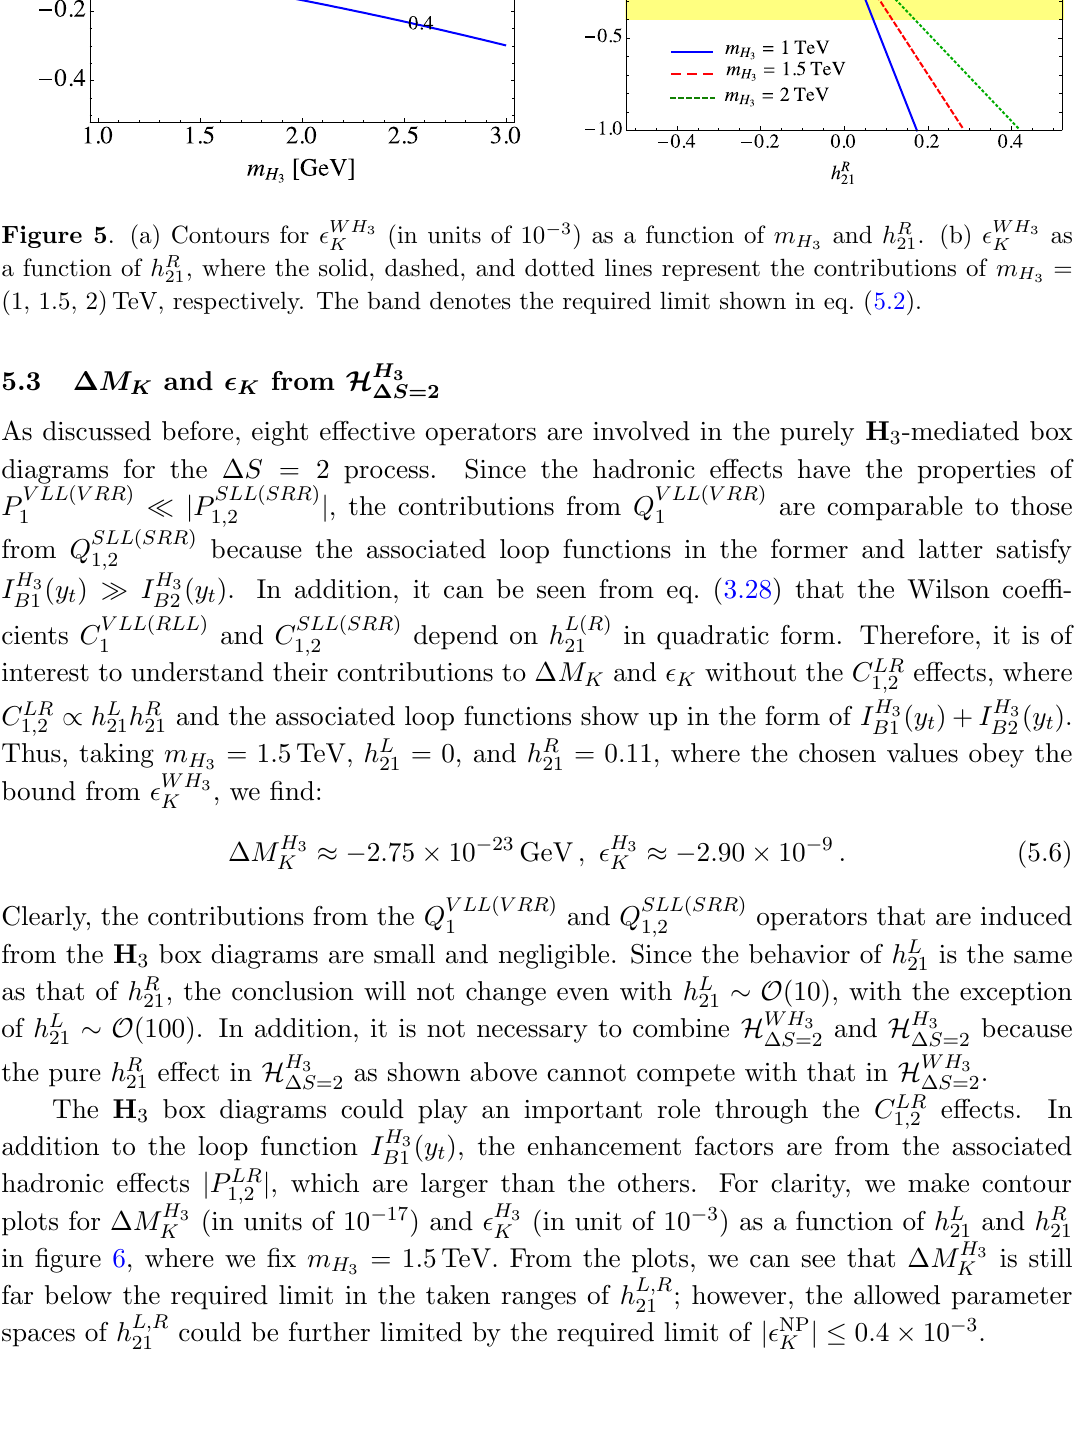
and h R . (b) (cid:15) WH 3 as 21 K 3 = 3